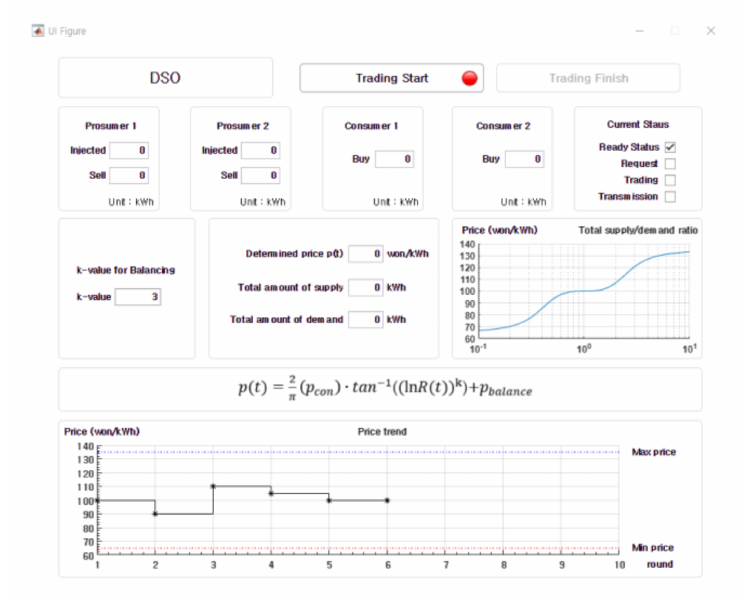
Figure 15. A GUI built with MATLAB for experimentation.